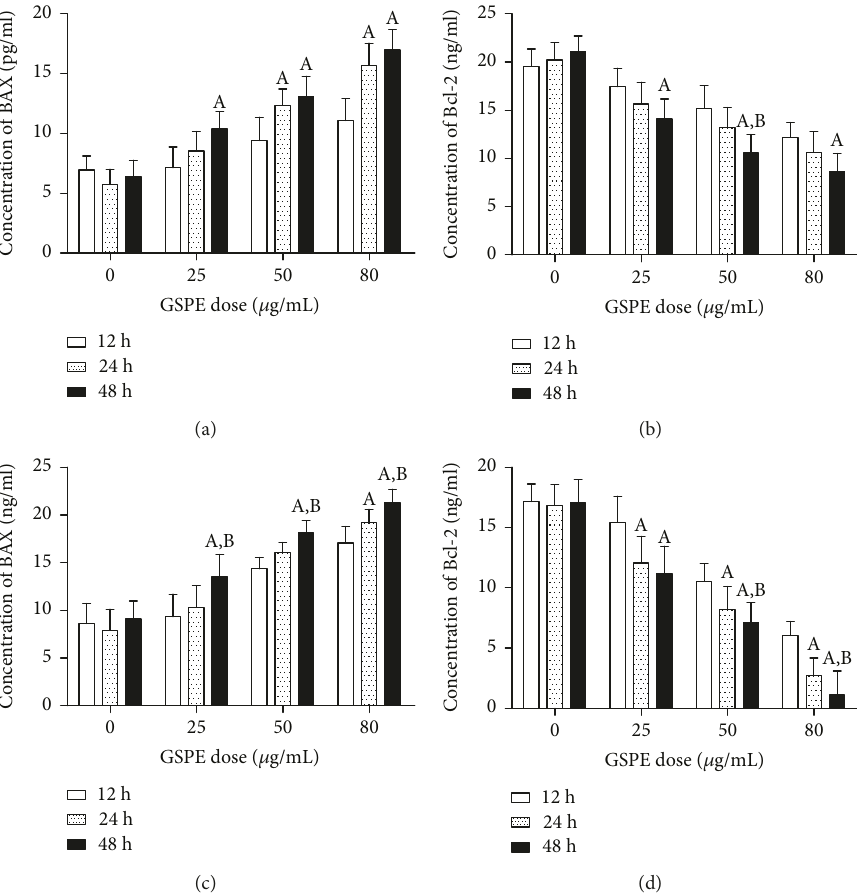
Figure 6: GSPE and BAY11-7082 inhibited Bax/Bcl-2 expression in ECA109 cells. (a, b) GSPE inhibited Bax and Bcl-2 in cells. (c, d) GSPE +Bay11-7082 inhibited Bax and Bcl-2 in cells. Each column represents the mean ± SD of three groups of independent samples. A P < 0 05 compared with the 12h group; B P < 0 05 compared with the 24 h